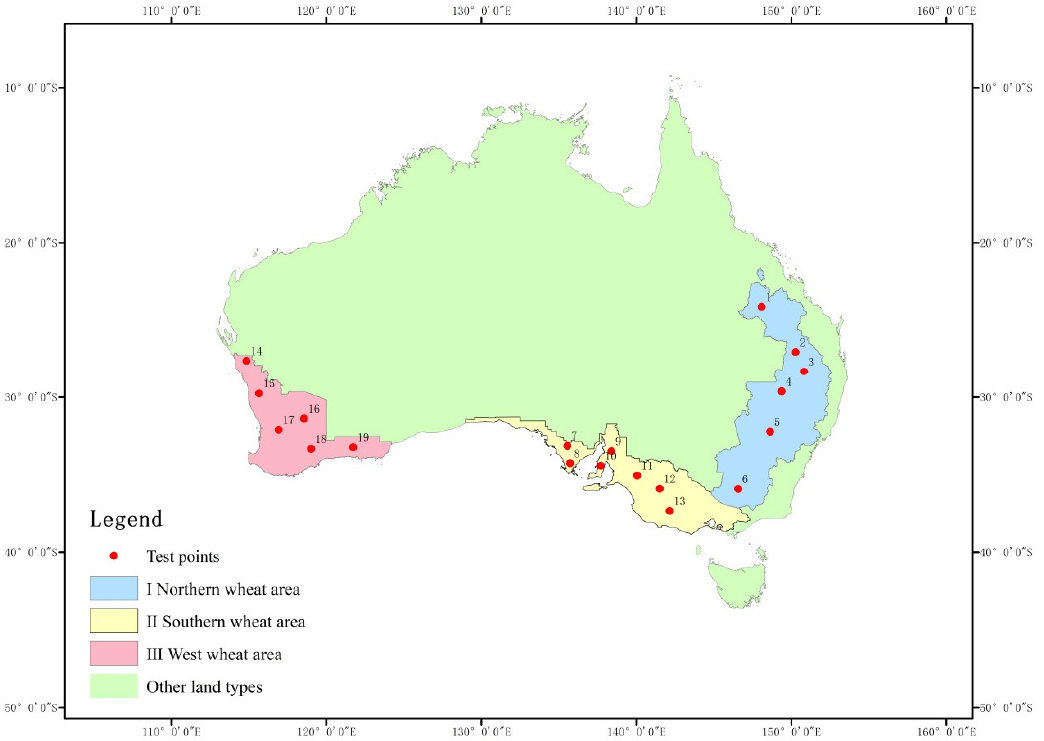
Figure 1. Location of the study area and the distribution of observation sites.